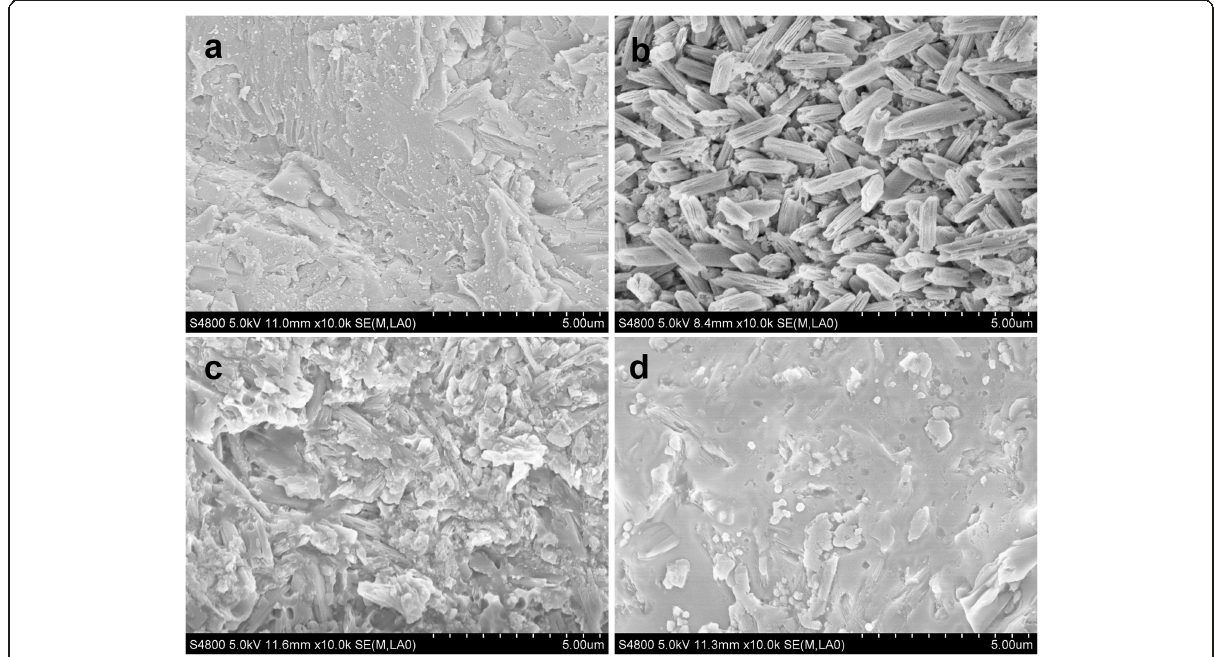
Fig. 7 SEM images of customized ceramic bracket base at 10 k×: a without etching; b hydrofluoric acid etching. And debonding base at 10 k×: c CCB-E; d CCB-ES